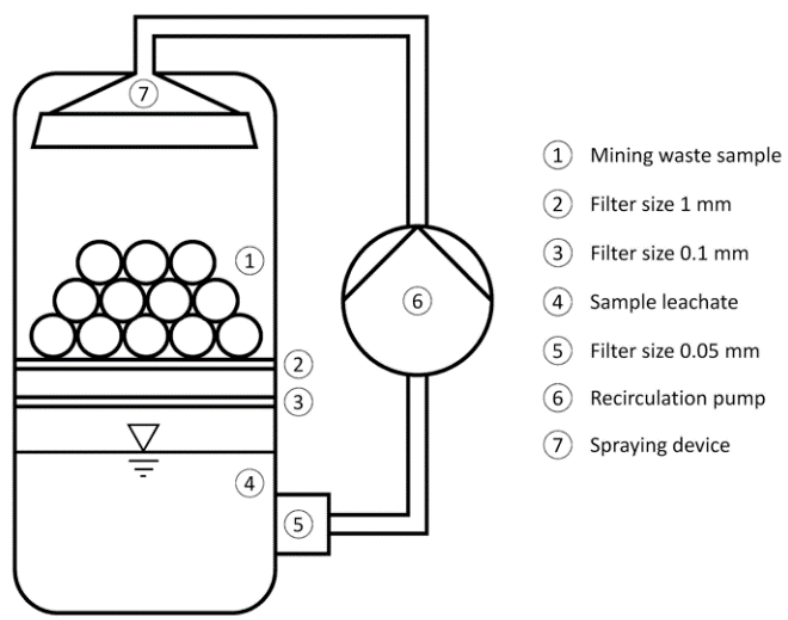
Figure 2. Equipment for leaching mining waste in an acidic media, ambient temperature and atmospheric pressure. Own elaboration.